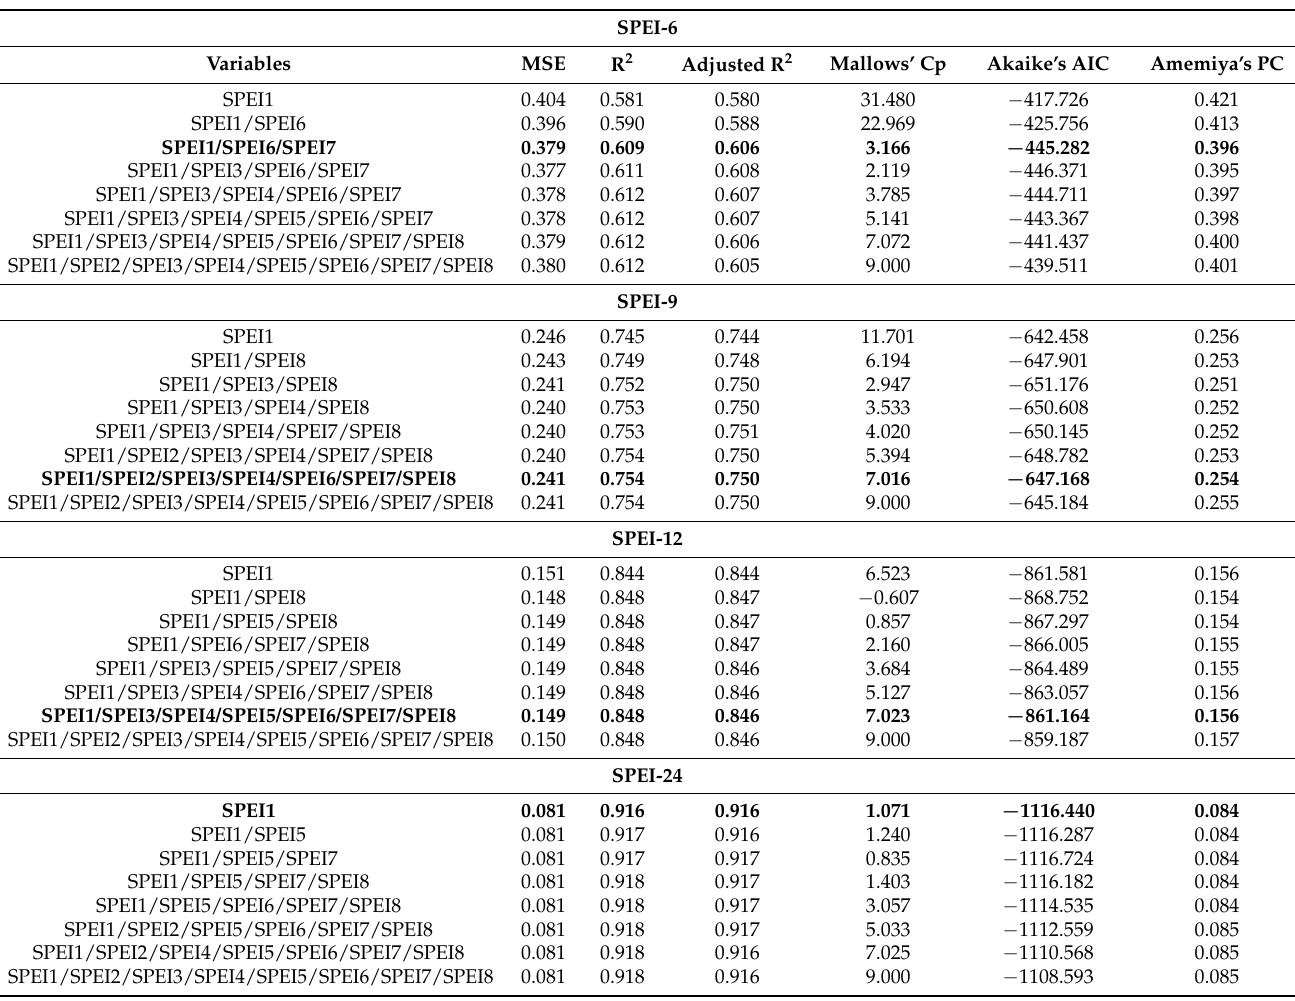
Table 3. The best subset regression analysis for determining the best input combinations to model. SPEI-6 Variables